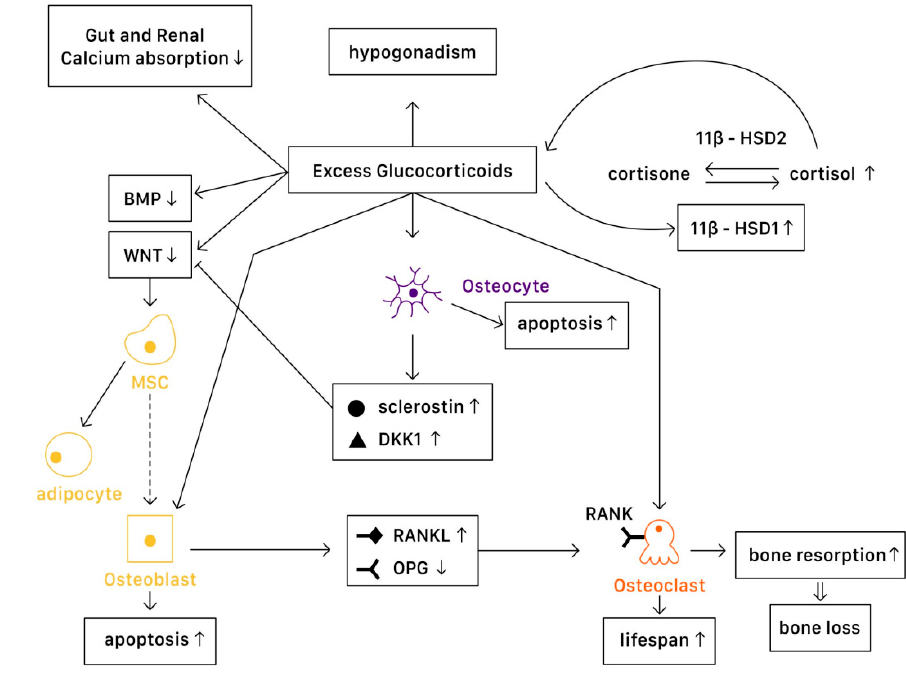
Figure 3. The mechanisms of glucocorticoid-induced osteoporosis (GIOP) .